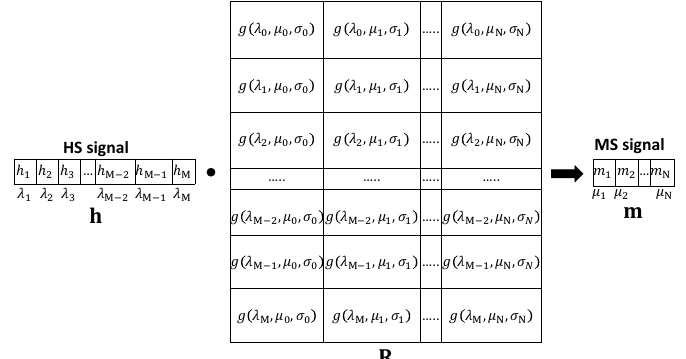
Figure 1. Tunable spectral sub-sampling layer.